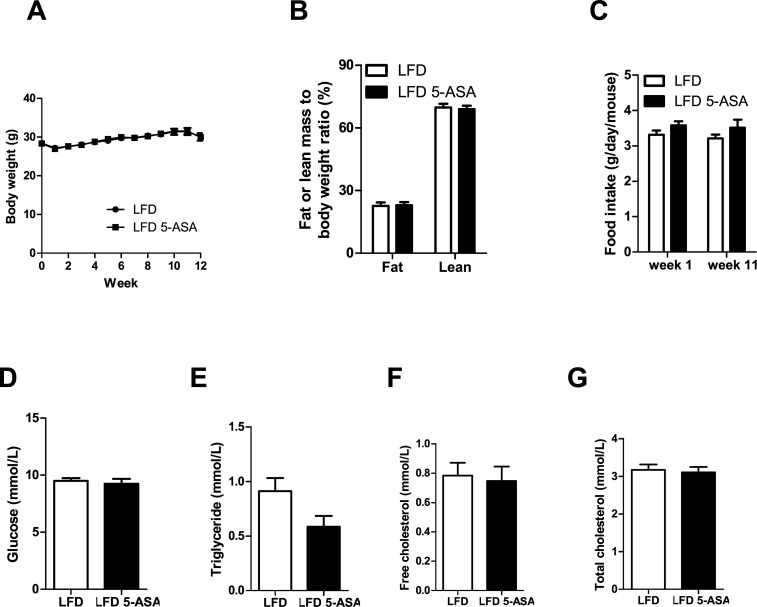
5-ASA treatment does not affect the metabolic parameters in mice fed LFD.(A) Body weights of LFD and LFD 5-ASA-fed C57BL/6J mice over time, starting at 10–12 weeks of age. (B) Fat or lean mass, expressed as percentage of body weight, were analyzed after 12 weeks of LFD or LFD 5-ASA. (C) Food intake of mice fed LFD and LFD 5-ASA at the first week and week 11. (D) Fasting glucose of 11-week LFD or LFD 5-ASA-fed mice. (E-G) Plasma triglycerides, free cholesterol and total cholesterol were quantitatively analyzed in mice fed 12 weeks of LFD or LFD 5-ASA. Data are presented as means ± SEM, n = 9–10 mice.